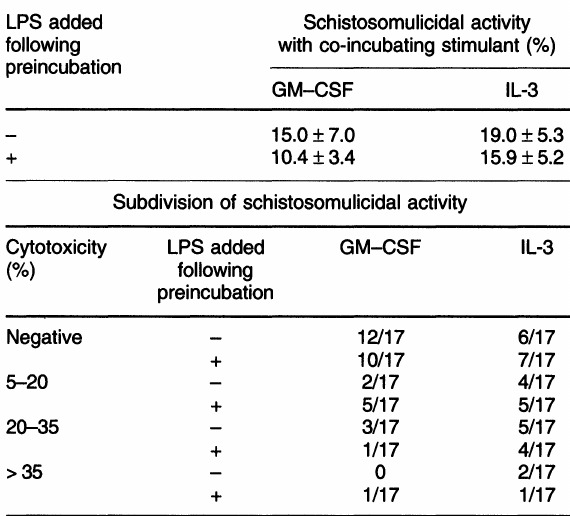
Table 1. Influence of various stimulators on the schistosomulicidal activity of human monocytes/macrophages LPS added following